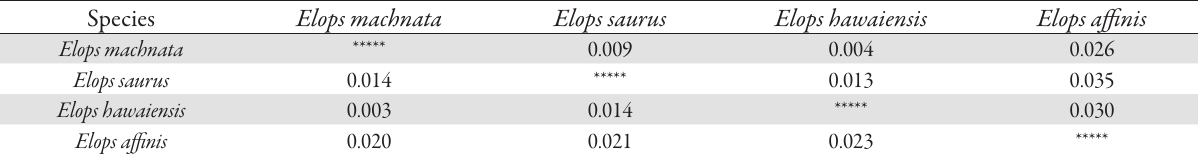
Tab. 2. K2P genetic distance between Elops species based on CO1 gene sequences (below diagonal), based on 12S rRNA gene sequences (above diagonal)